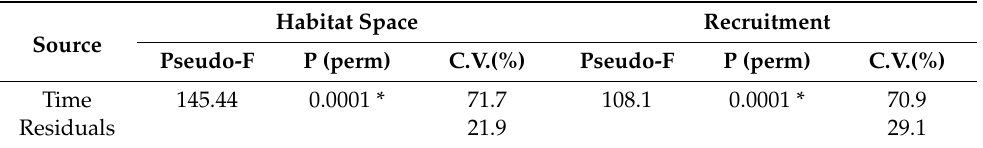
Figure 4. Boxplots of changes in colony volume over time. Corals were monitored bi-monthly for two years, with 0 representing the time when coral fragments were transplanted. The bars indicate the average (with the representation of the median) volume of fragments per time point. Y -Axis break was used to shrink a segment and enhance the readability of fragment volume change in the chart. Letters indicate significant differences between groups. Table 1. One-way univariate ANOVA with repeated measures based on permutations evaluating differences in coral growth as the volume, and recruitment of Trapezia , between time (T).